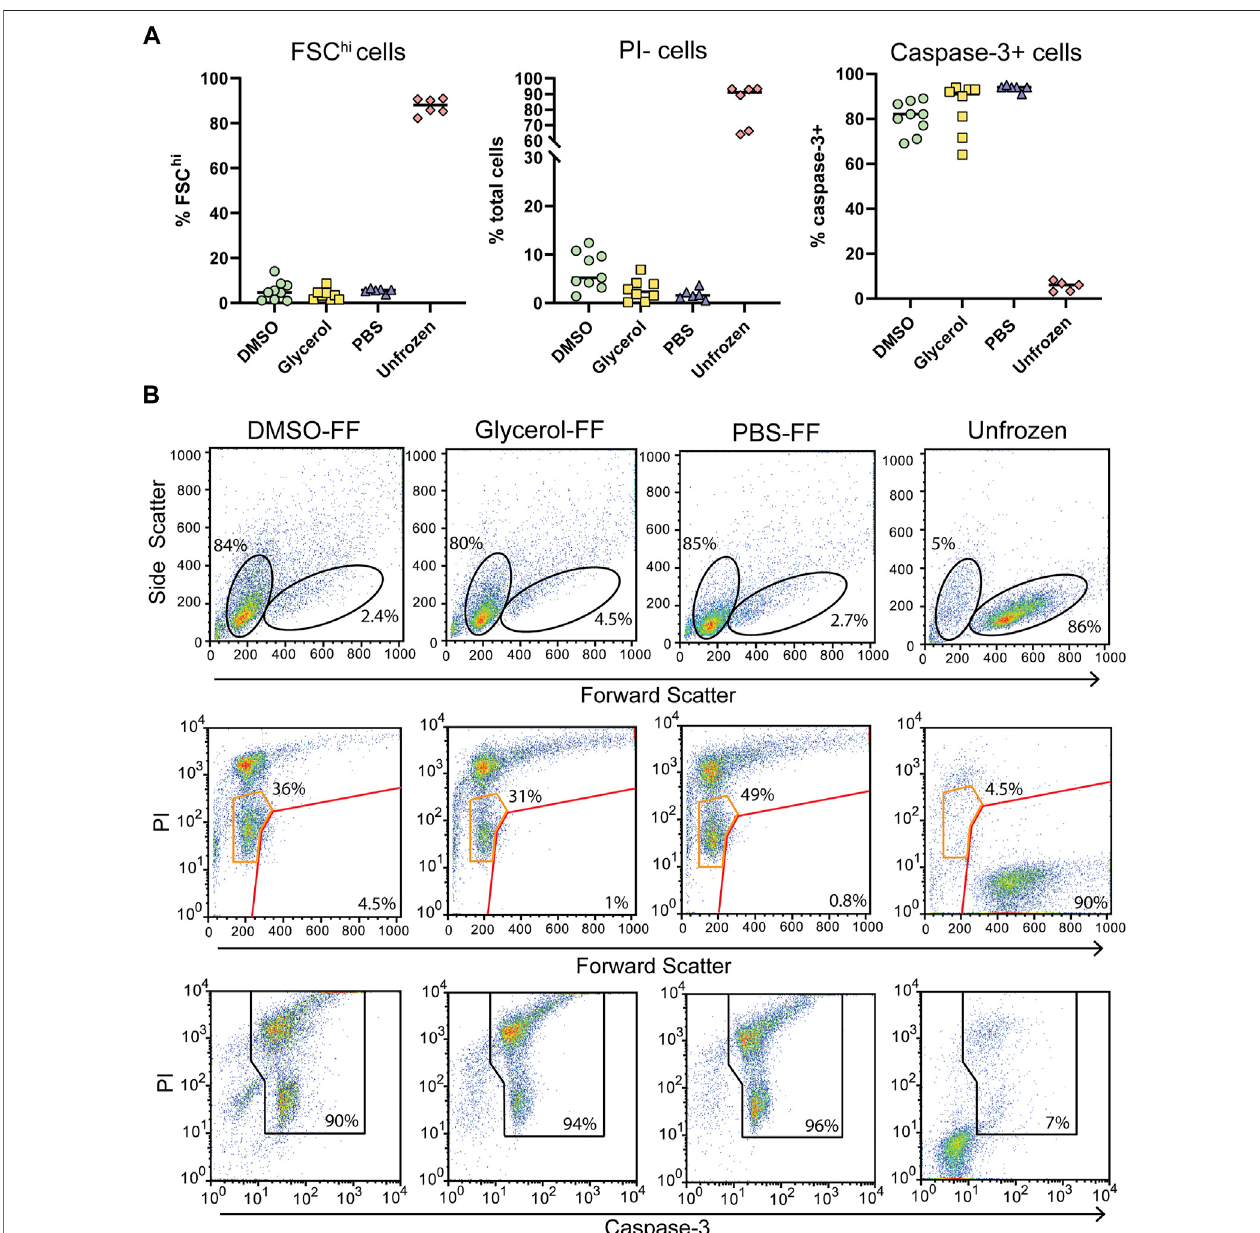
FIGURE4| PostDNPcellularintegrityandapoptosisinductionwith fl ash-freezing(FF). (A) Post-thawviabilityasdeterminedbyFSC fl uorescence,PI,andcapsase- 3 staining. Each symbol represents a single rotor. (B) Representative fl ow cytometry plots of samples treated with various cryoprotecting reagents followed by fl ash- freezing(FF).ToppanelsshowthegatingstrategyusedtodetermineFSC hi cells.MiddlepanelsshowPIuptakeofFSC hi cells(redgate)andFSC lo cells(orangegate)cells Bottom panels show the gating strategy used to determine caspase-3+